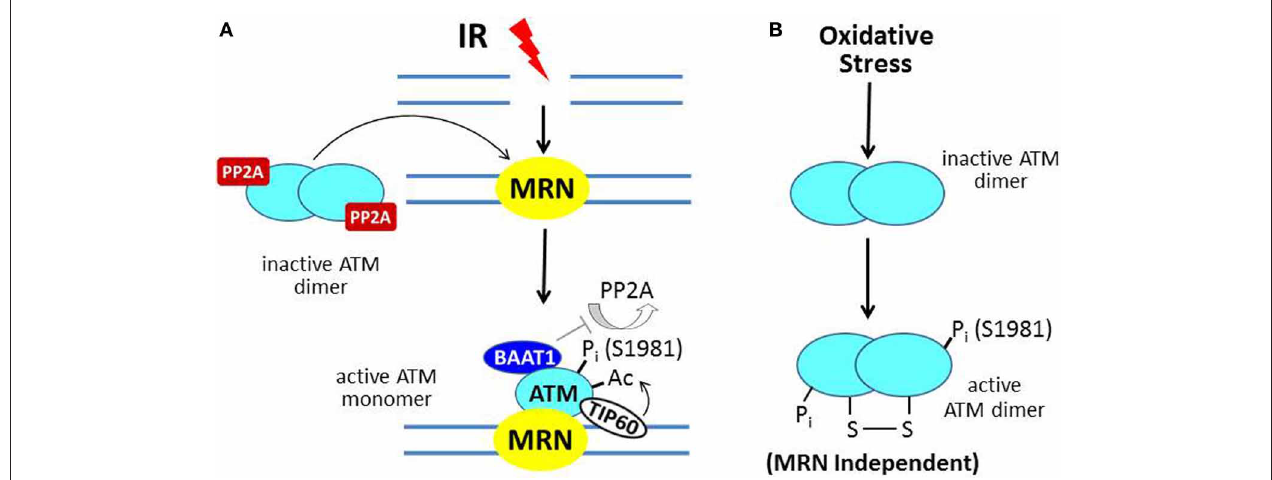
FIGURE 2 | ATM activation by ionizing radiation (IR) vs. oxidative stress. (A) In IR-induced activation, the MRN complex, a DNA damage sensor, is recruited to DSBs; and MRN then recruits ATM. In undamaged cells, ATM is a dimer held in the inactive state by PP2A. After IR, PP2A dissociates from ATM, allowing autophosphorylation on S1981 and conversion to a monomer at the MRN/DSB site. The protein